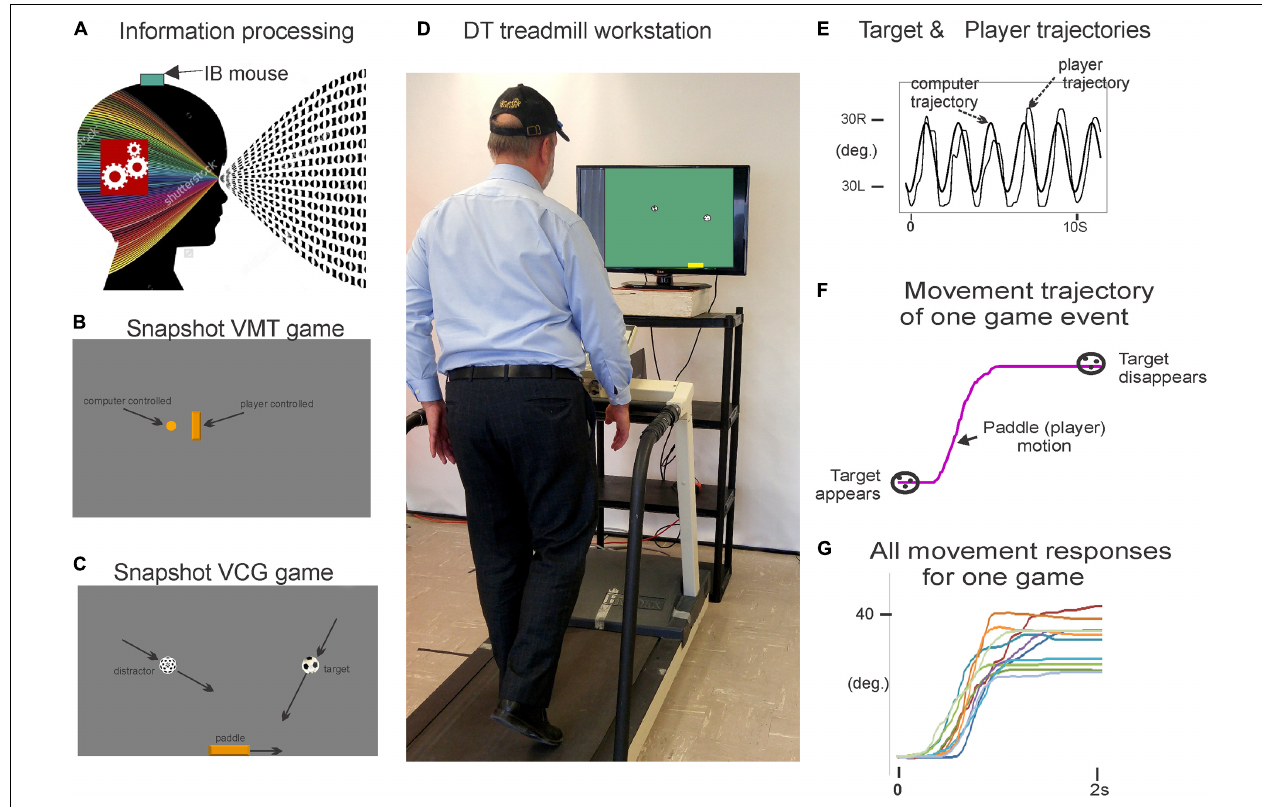
FIGURE 1 | Illustration of the treadmill platform and experimental set-up; (A) the motion mouse is shown attached to the head via a baseball cap. (D) Participant is walking on the instrumented treadmill while viewing a computer monitor. Head rotation (via motion mouse) is used to interact with the visuospatial cognitive task. (B,C) present snap shots of the VMT and VCG. (E) Presents synchronous plots of the target cursor motion and user movement trajectories (head rotation) for a typical VMT task. Maxima are the left most position and minima the right most position. (F) Presents the trajectory for one game movement response from target appearance to target disappearance. (G) Presents overlay trajectories of all game movement responses for one game session. Parts of Figure 1 have previously been published in Szturm et al. (2017, 2021).